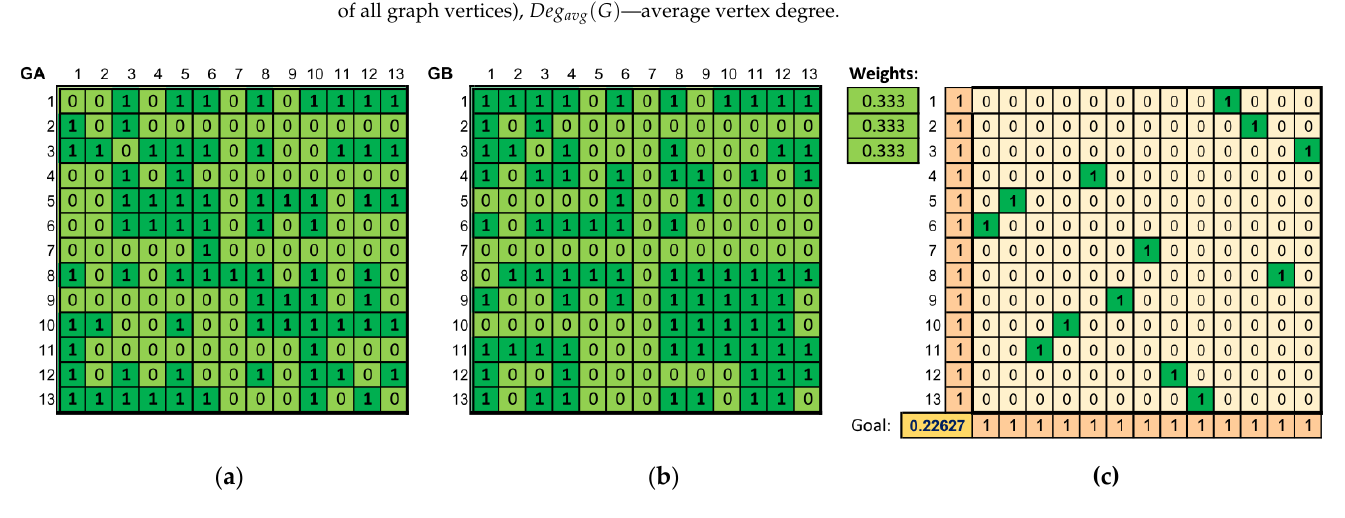
Figure 3. Comparison of L. van Beethoven’s Für Elise and Nocturne Op. 9 by F. Chopin. ( a ) The adjacency matrix of the graph representing the first piece. ( b ) The adjacency matrix of the graph representing the second piece. ( c ) The optimal assignment matrix of vertices from one graph to another (maximizing graph similarity) together with the value of the objective function.